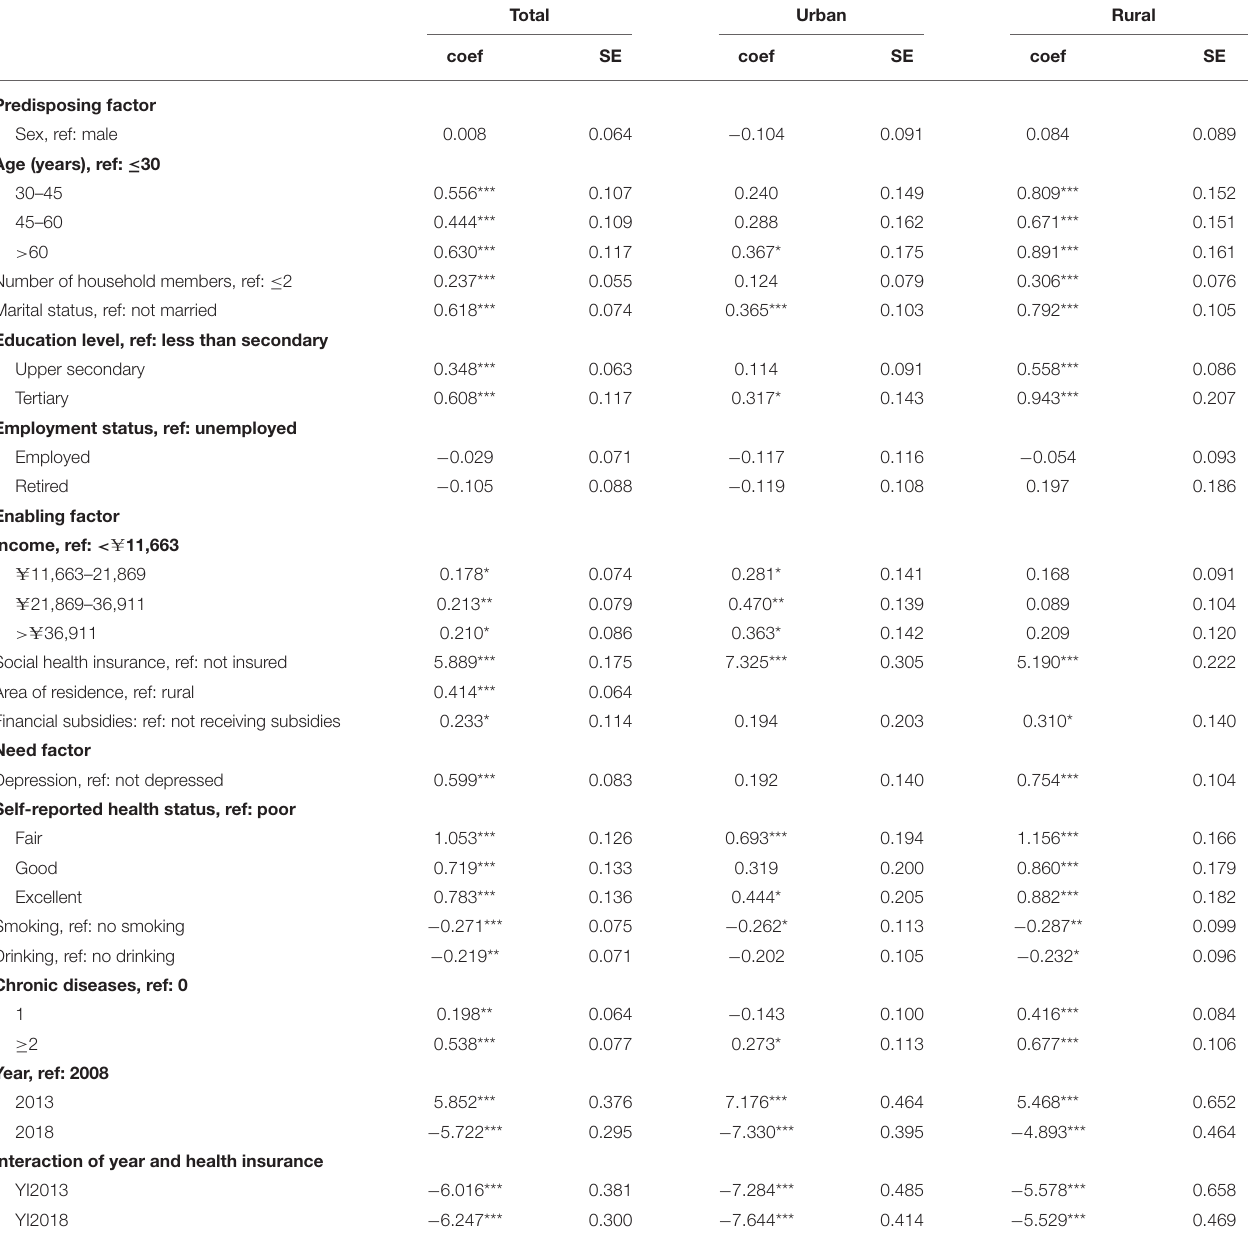
TABLE 3 | Regression analysis of annual total health expenditure (log) of urban and rural